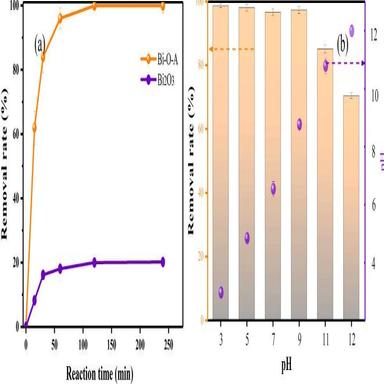
(a) Bi–O-A removal As(V), (b) The influence of pH on Bi–O-A removal As(V) (Test condition: initial arsenic concentration 10 mg/L, dosage 1 g/L, stirring speed 400 rpm, T = 25 ± 1 ◦C).